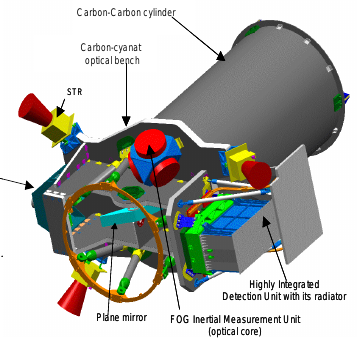
Figure 5: Instrument Configuration Optical Architecture